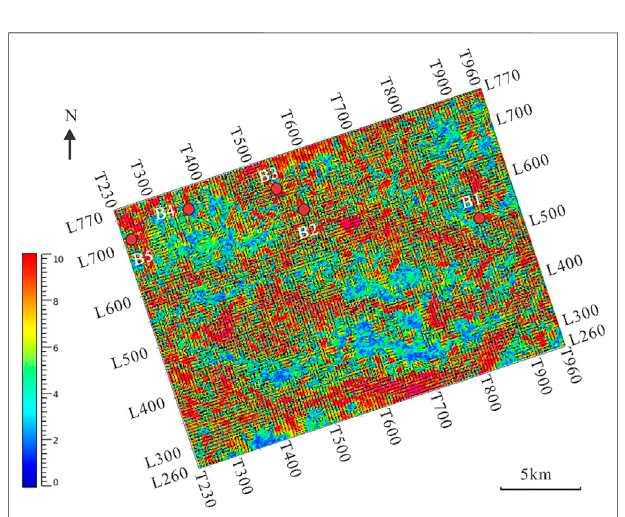
FIGURE 9 | Superposition plane of pre-stack AVAZ fracture strength and orientation in the upper sweet spot.